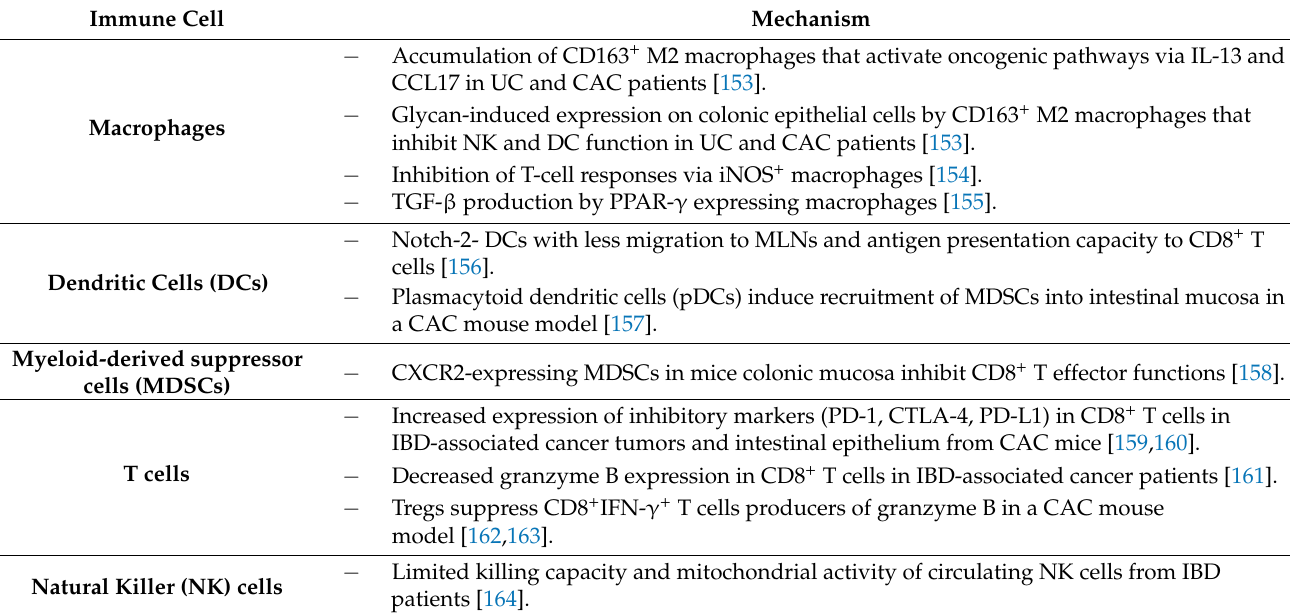
Table 1. Possible anti-inflammatory and immunosuppressive mechanisms that may dampen immunosurveillance during IBD-associated